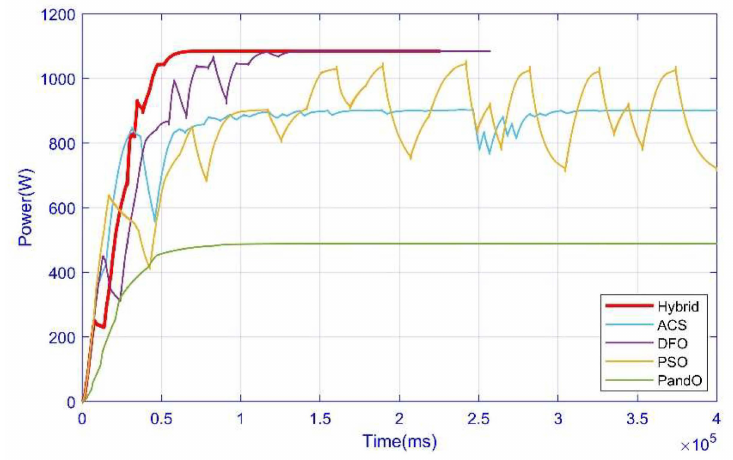
Figure 17. Case 4: Power comparison of hybrid with other techniques.